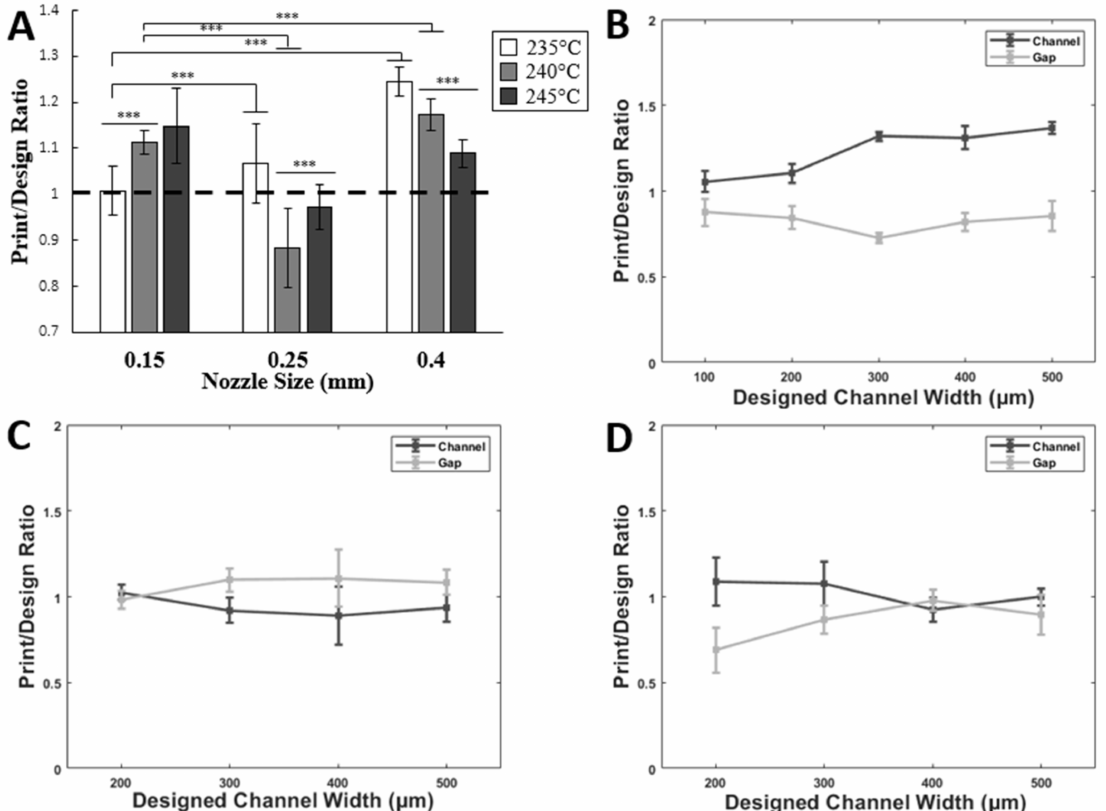
Figure 3. Optimizing FDM print resolution. ( A ) When ABS filaments were printed at various temperatures, accurate line widths compared to their nozzle sizes were obtained at 235, 245, and 245 ◦ C for 0.15 mm, 0.25 mm, and 0.4 mm nozzles, respectively. At these optimal temperatures, alternating bands with line widths of 100 to 500 µ m, were printed at equal spacings. Data are represented as a ratio of printed over designed parts. Error bar S.E.M (N = 3), *** p -value < 0.001. ( B ) For the 0.15 nozzle, the most accurate printed lines were obtained near the 100 µ m designed width. Pearson’s r = 0.93 for channel and − 0.17 for gap. ( C ) For the 0.25 nozzle, the most accurate printed lines were obtained near the 200 µ m designed width. Pearson’s r = − 0.83 for channel and 0.59 for gap. ( D ) For the 0.4 nozzle, the most accurate printed lines were obtained near the 400 µ m designed width. These values allowed us to tailor slicer parameters that best suit the desired microfluidic geometries. Pearson’s r = − 0.72 for channel and 0.78 for gap. Data are represented as a ratio of printed channel/gap over designed parts for the same